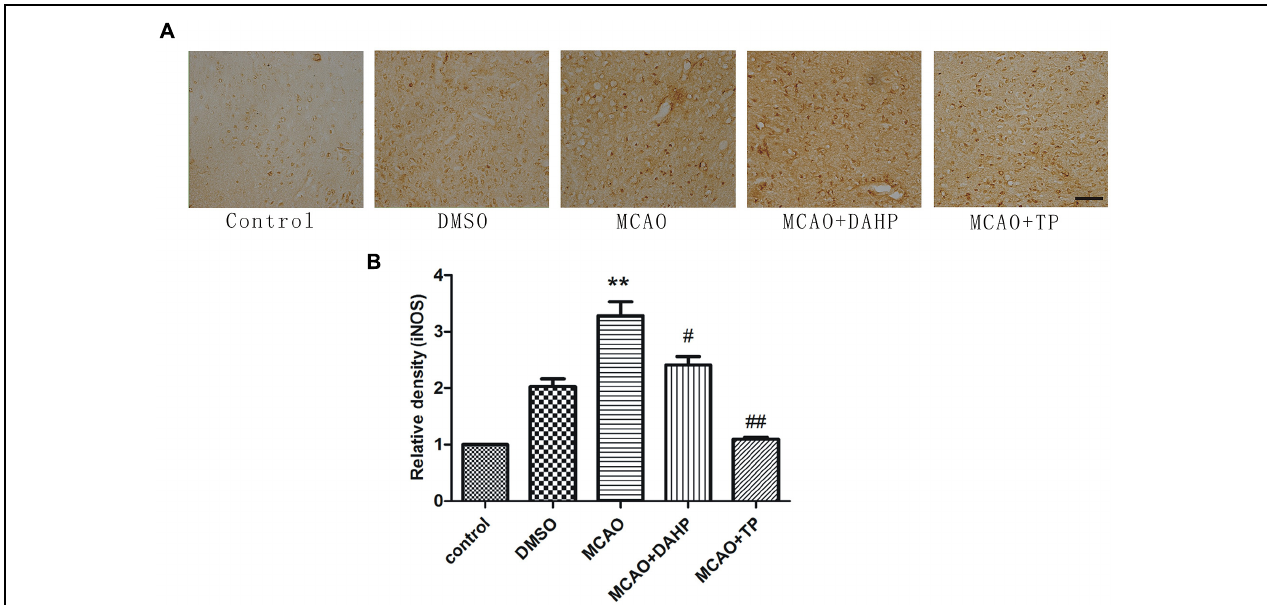
FIGURE 5 | 2, 4-diamino-6-hydroxypyrimidine and TP treatments attenuated iNOS expression in ischemic area. (A) Immunohisto- chemistry showed immunoreactivities of iNOS after MCAO. The profound expression of iNOS was observed in MCAO group compared to control